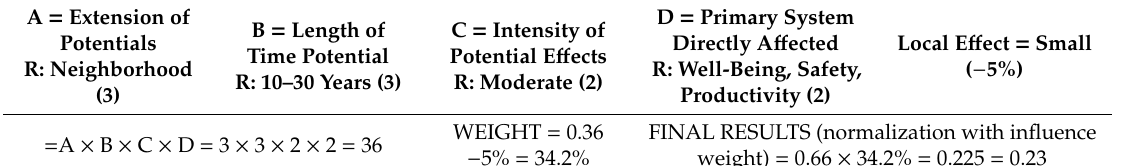
Table 6. Calculation of weighting and final result (category contribution)—urban quality.